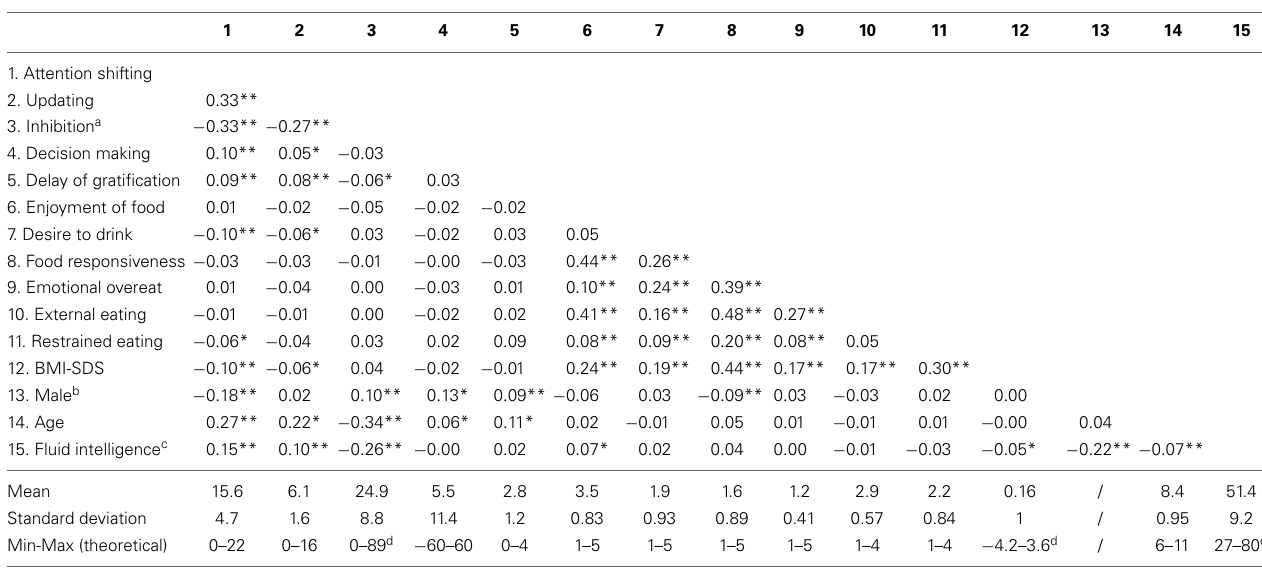
Table 1 | Descriptive statistics and intercorrelations of assessed